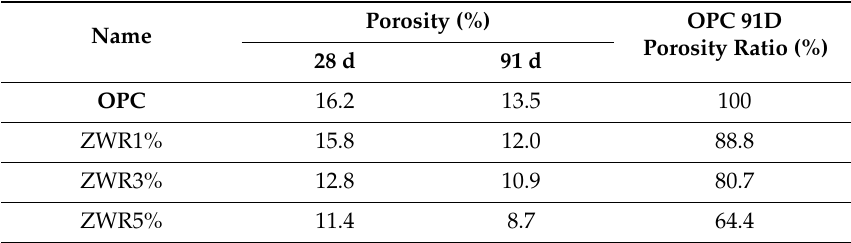
Table 8. Porosity measured by MIP (28, 91days).